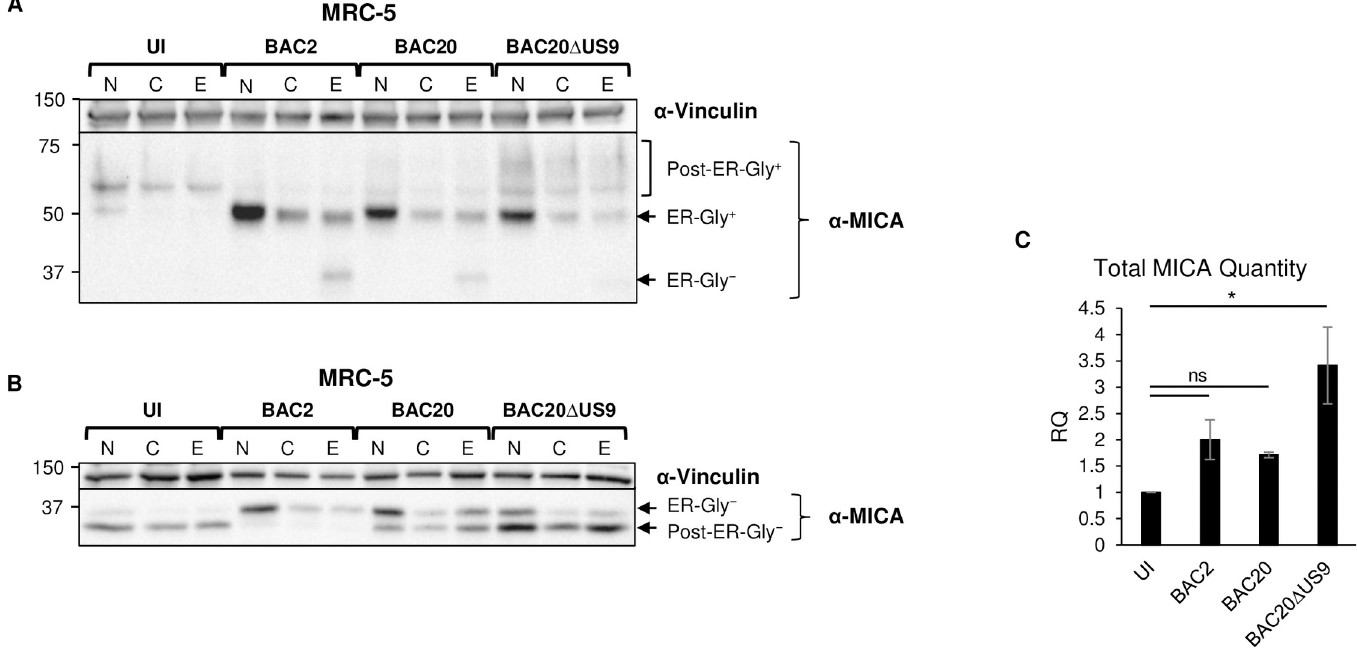
Fig 6. UL147A and US9 induce maturation arrest but also proteasomal degradation of MICA � 008 during HCMV infection. MRC-5 HLFs (MICA � 008 homozygous) were either uninfected (UI) or infected with the indicated HCMV strains. (A-C) Cells were either untreated (N), treated with cycloheximide and DMSO mock treatment (C) or treated with cycloheximide and epoxomicin (E), for 12 hr prior to harvesting at 72 hr post infection (hpi). (A, B) Lysates were prepared and either untreated (A) or deglycosylated with PNGaseF (B). A western blot was performed using anti-MICA antibody for detection of MICA and anti-vinculin antibody as a loading control. (C) Quantification of untreated (N) deglycosylated MICA � 008 forms shown in (B). MICA levels were quantified relative to the loading control. RQ, relative quantification. Data show mean ± SEM for three independent experiments. A one-way ANOVA was performed with a significant effect at the p < 0.05 level for all conditions [F (3,8) = 6.08, p = 0.018]. A post-hoc Dunnett’s test was used to compare UI MICA protein levels to each infected cell. � p < 0.5, ns not significant. Full experimental data and statistics can be found in S1 Data.